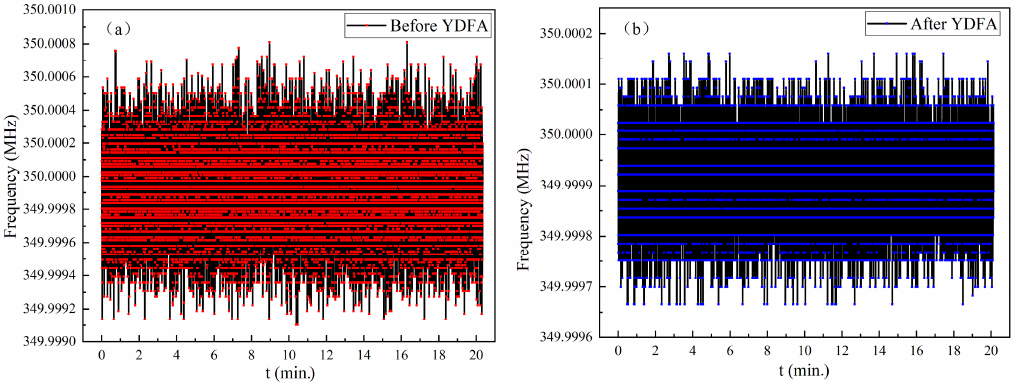
Figure 6. Stability of the spectra of modulation ( a ) before and ( b ) after amplification.